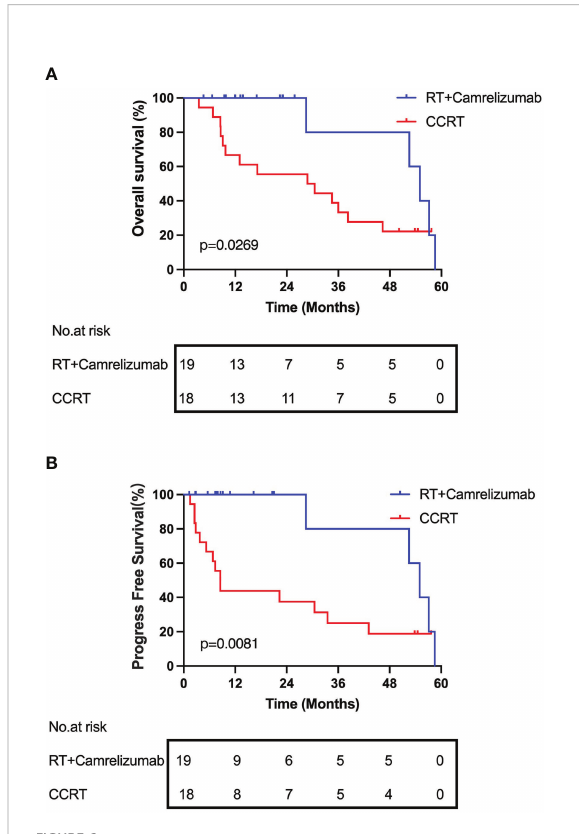
FIGURE 6 Prognosis of patients receiving RT plus camrelizumab or CCRT treatment. (A) OS. (B)